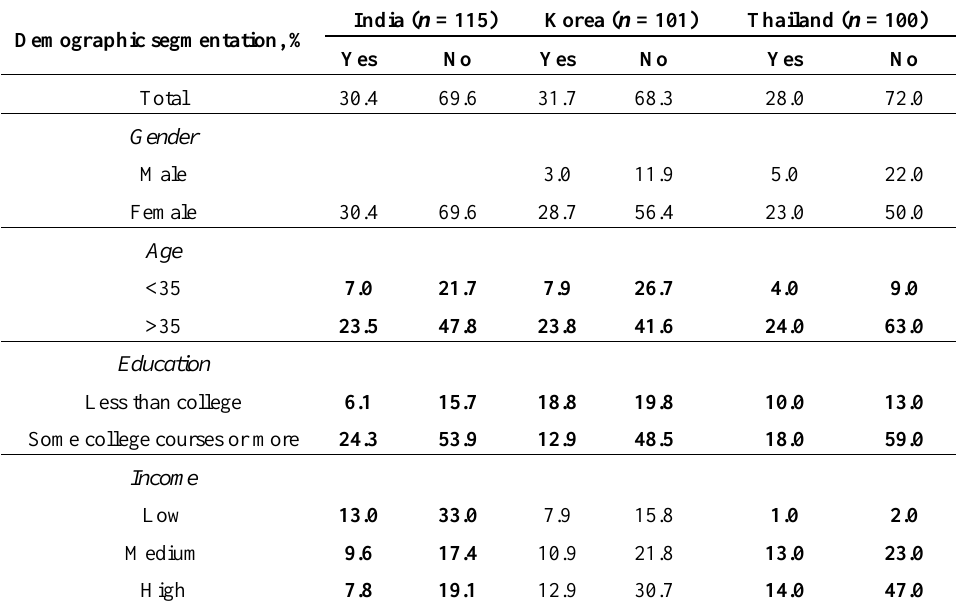
Table 7. Consumers’ raw meat, seafood, and poultry storage behavior. Would you place something under the raw meat in the refrigerator (Yes/No)? India ( n = Demographic segmentation, %